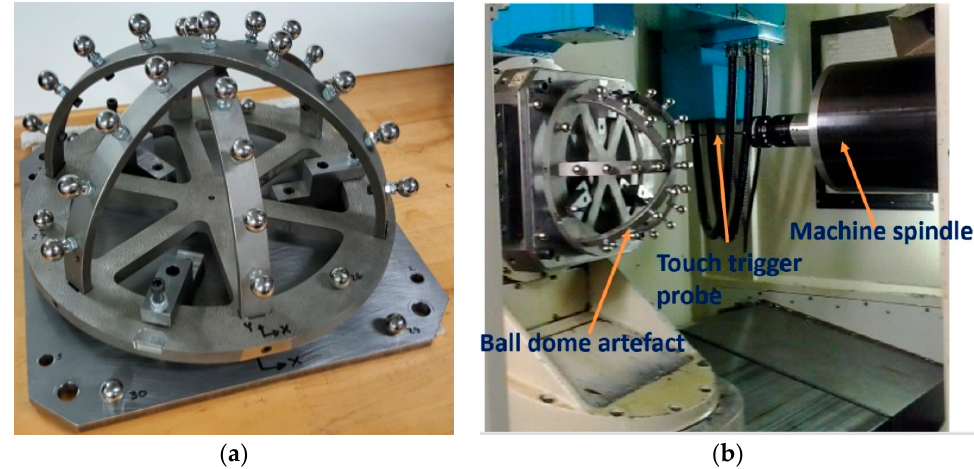
Figure 3. ( a ) Ball dome artefact, ( b ) the ball dome holds on the machine tool work table.